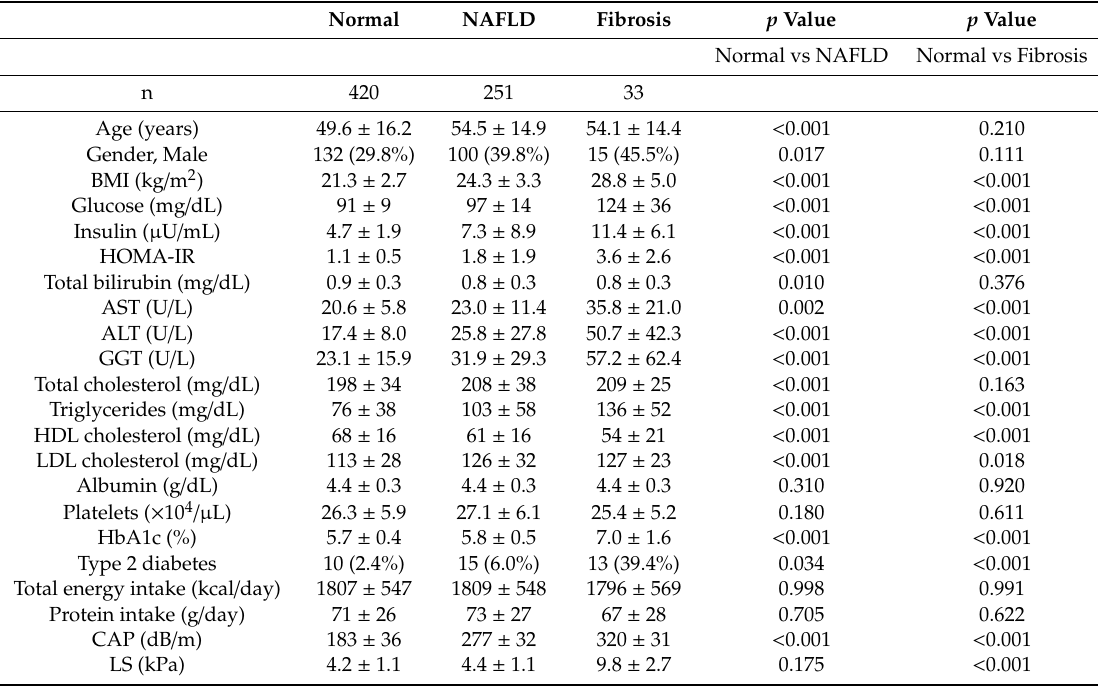
Table 1. Participants’ characteristics at baseline.